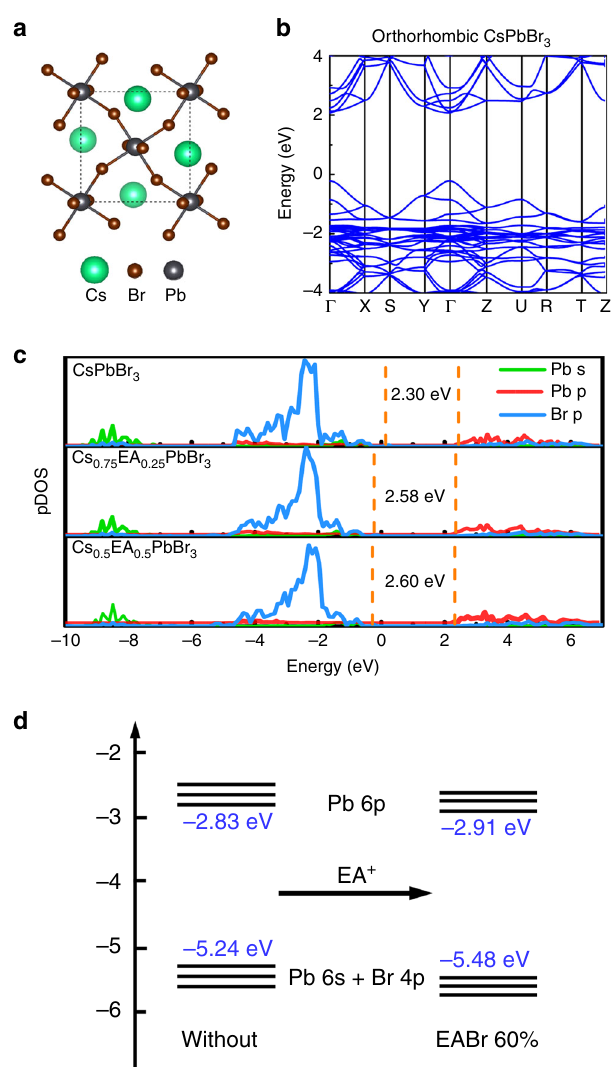
Fig. 3 The crystal structures and electronic structures of different perovskites. a The crystal structures of CsPbBr 3 . b The electronic structures of CsPbBr 3 . c The calculated electronic density of states (DOS) of CsPbBr 3 , Cs 0.75 EA 0.25 PbBr 3 , and Cs 0.5 EA 0.5 PbBr 3 . d Schematic representation of variation of energy levels of quasi-2D perovskite in Pb 6p and (Pb 6s + Br 4p) orbitals on insertion of EA cation. The valence band maximum (VBM) and conduction band minimum (CBM) come from (Pb 6s + Br 4p) and Pb 6p orbitals,